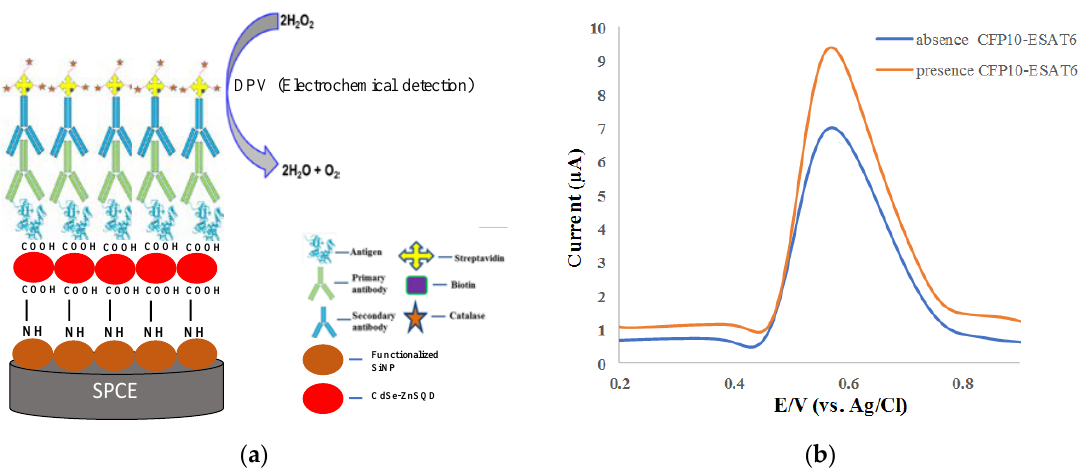
Figure 5. ( a ) Schematic diagram of electrochemical immunoreaction for differential pulse voltammetry (DPV) response of oxidation of H 2 O 2 to produce water molecule and oxygen catalyzed by catalase for the detection of CFP10–ESAT6; ( b ) DPV current response of H 2 O 2 oxidation for immunoassay in the absence and presence of 0.12 µ g / mL CFP10–ESAT6 protein in 0.1 M PBS (pH = 7.4) containing 150 µ M H 2 O 2 .